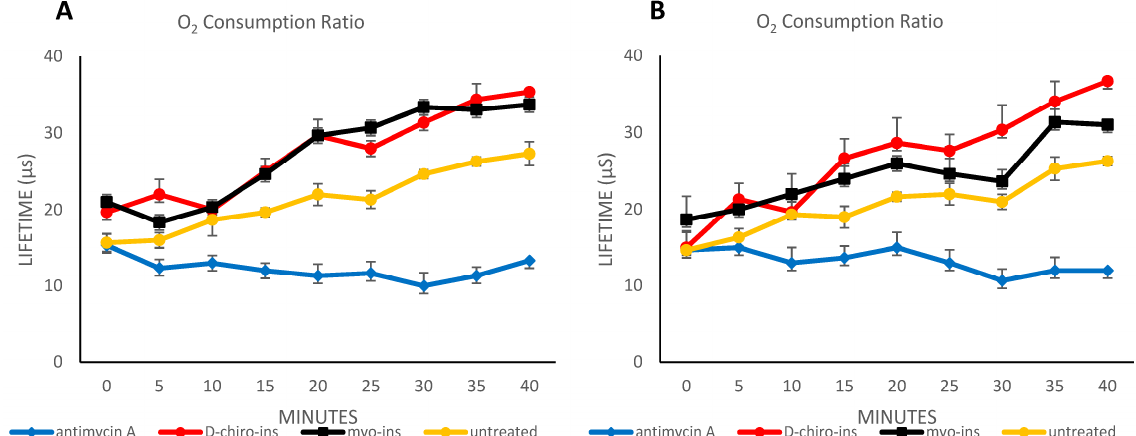
Figure 2. Modulation of mitochondrial DNA copy number in ( A ) SGBS cells and ( B ) LiSa-2 cells. SGBS and LiSa-2 di ff erentiated adipocytes were treated with D-chiro-Ins (60 µM) and myo-Ins (60 µM) for 72 h, with a single medium change at 36 h. Results are reported as mean ± SD of data obtained from 3 independent experiments in technical triplicate. Relative DNA mitochondrial copy number was calculated from the di ff erence between the threshold cycle (CT) values for mitochondrial DNA and nuclear speci fi c ampli fi cation. Bars show log 2-fold change (treated vs. control). Data were analyzed by one-way ANOVA. p -values ≤ 0.05 were considered statistically signi fi cant. ** p < 0.01 versus control.